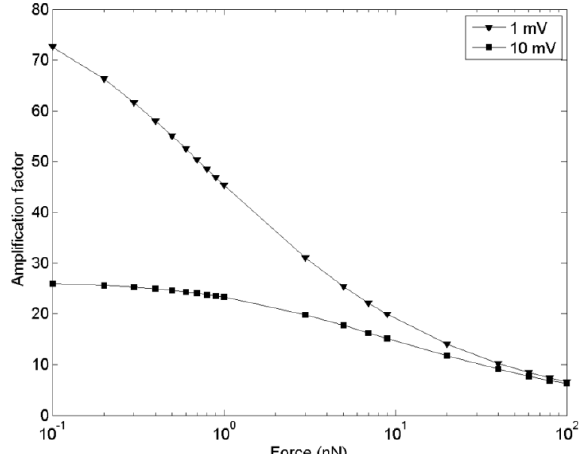
Figure 2. Ampli fi cation factor vs. various applied force. The applied voltage is 1 mV and 10 mV under the pull-in